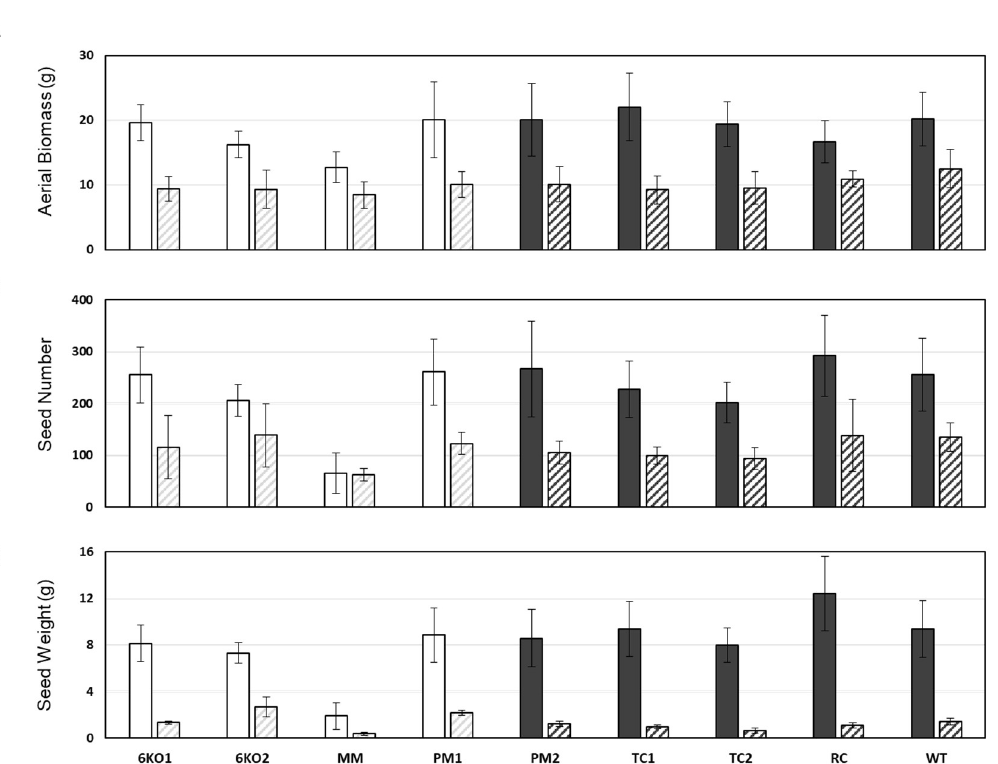
Figure 5. Comparison of growth in well-watered plants (solid) vs mild drought treatment (diagonal pattern) per plant: ( A ) aboveground dry biomass (g), ( B ) seed number, ( C ) total seed weight (g). White bars indicate plants with mutant stem phenotype; dark grey bars indicate plants with wildtype stems. Error bars indicate standard deviation (n = 4). Data is representative of 3 independent experiments.